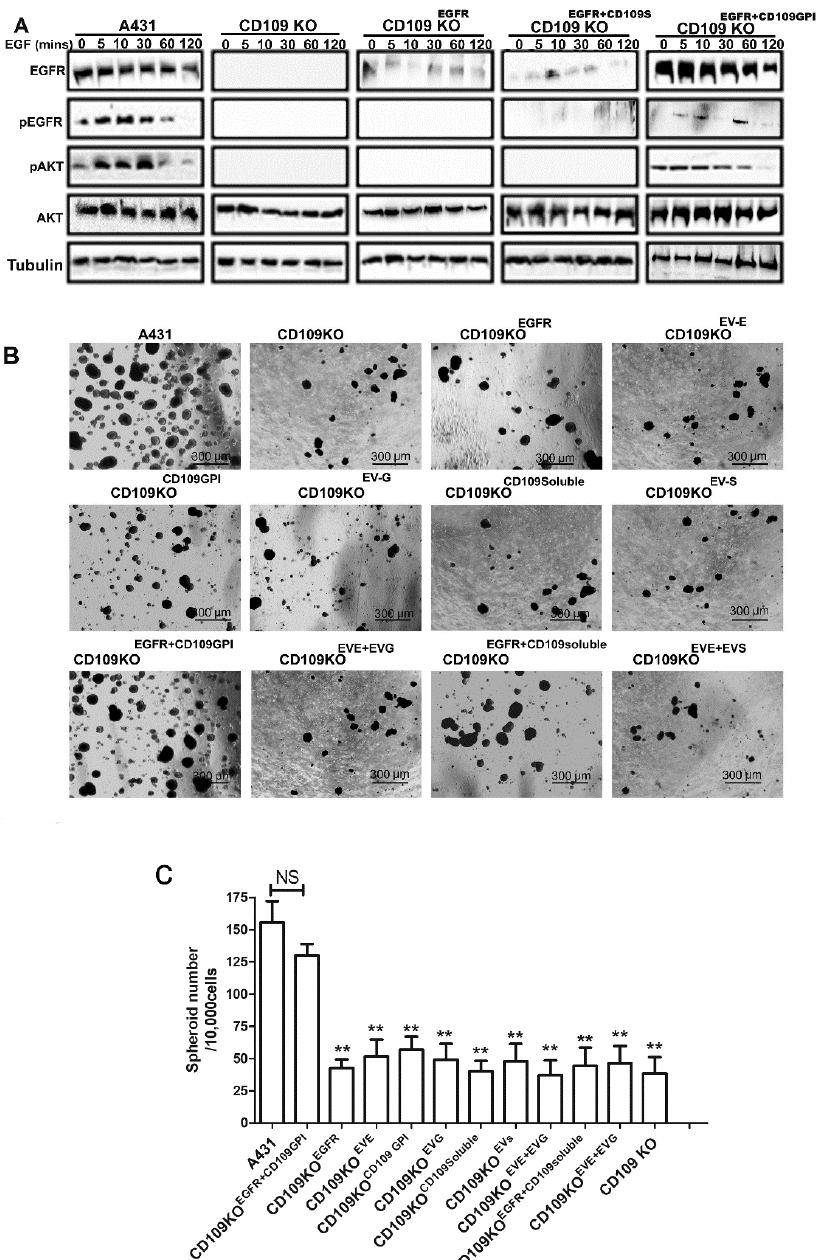
Figure 7. CD109 is required for EGF-mediated regulation of EGFR levels, AKT signaling, and to maintain stemness in SCC cells. Co-expression of GPI-anchored CD109 and EGFR (but not EGFR or GPI-anchored CD109 or soluble CD109 alone or co-expression of soluble CD109 with EGFR) restores EGFR expression, phospho-EGFR, and phospho-AKT levels, and tumorigenicity in CD109 KO SCC cells. ( A ) Western blot analysis for the indicated proteins of control A431 cells or CD109KO cells transfected with the indicated plasmids. All cells were serum-starved overnight, then treated with 100 ng/mL of EGF for indicated time points before Western blot analysis. ( B ) Representative images of tumor spheroids formed by control A431 cells or CD109KO cells transfected with the indicated plasmids as in A. ( C ) Quantification of the number of tumor spheroids formed in B. Five random fields were photographed, and the number of tumor spheroids was analyzed. All the results were expressed as the mean ± S.D. of three independent experiments. Significance was calculated using a One-Way ANOVA: ** p < 0.01. Uncropped WB images were shown in Figure